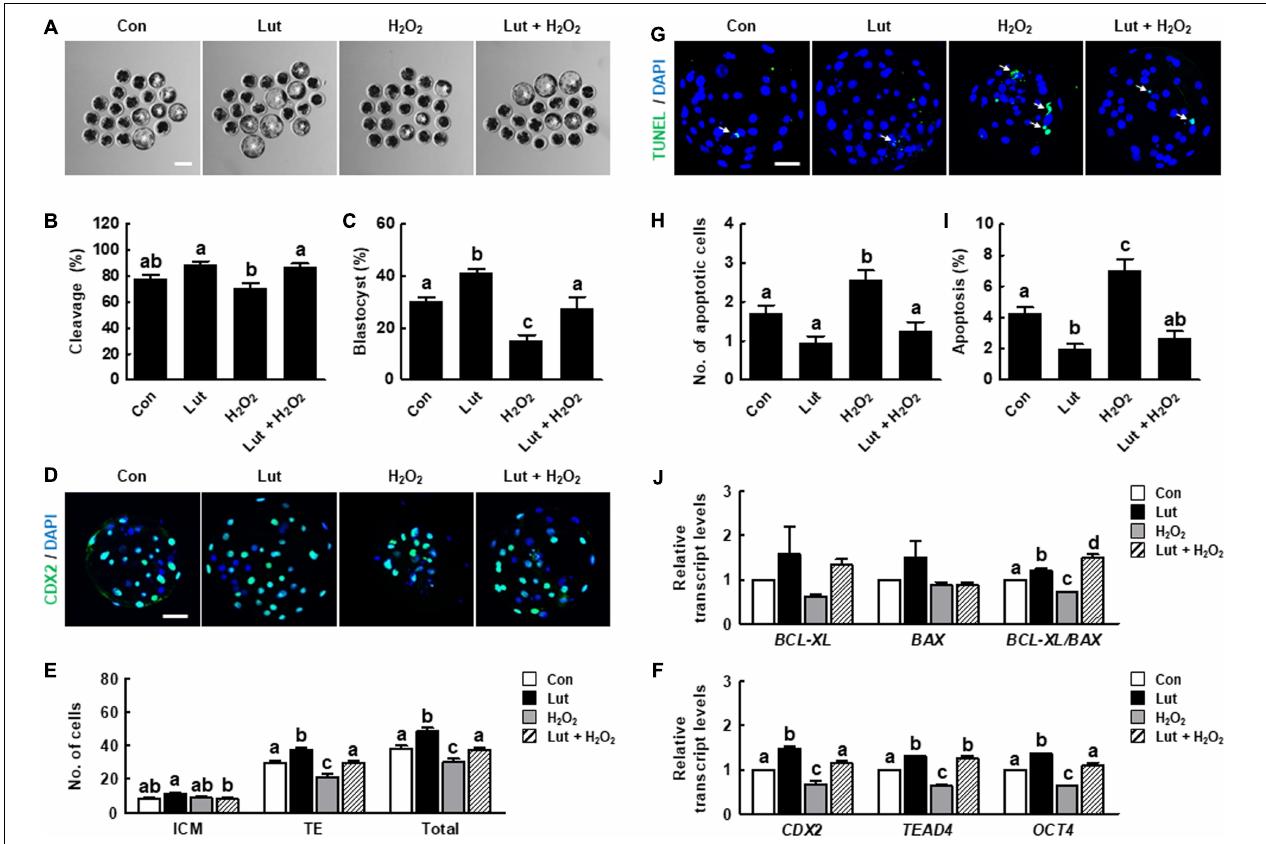
FIGURE 6 | Effects of Lut during IVM on the developmental competence of in vitro fertilization (IVF) embryos. (A) Representative images of blastocyst formation at 6 days after IVF in the indicated groups. Scale bar = 100 µ m. Rates of (B) cleavage and (C) blastocyst formation in the indicated groups (Con, n = 144; Lut, n = 145; H 2 O 2 , n = 134; Lut + H 2 O 2 , n = 133). (D) Representative images of Cdx2- and DAPI-stained blastocysts in the indicated groups. Scale bar = 50 µ m. (E) Number of inner cell mass (ICM), trophectoderm (TE), and total cells in the indicated groups (Con, n = 20; Lut, n = 20; H 2 O 2 , n = 20; Lut + H 2 O 2 , n = 20). (F) Relative expression of ICM/TE differentiation-related genes in the indicated groups. (G) Representative images of TUNEL- and DAPI-stained blastocysts in the indicated groups. Scale bar = 50 µ m. (H) Number of apoptotic cells and (I) the apoptosis rate in the indicated groups (Con, n = 20; Lut, n = 20; H 2 O 2 , n = 20; Lut + H 2 O 2 , n = 20). (J) Relative expression of apoptosis-related genes and the ratio of BCL-XL / BAX levels in the indicated groups. The data are from at least three independent experiments, and the different superscript letters represent the significant difference ( p <